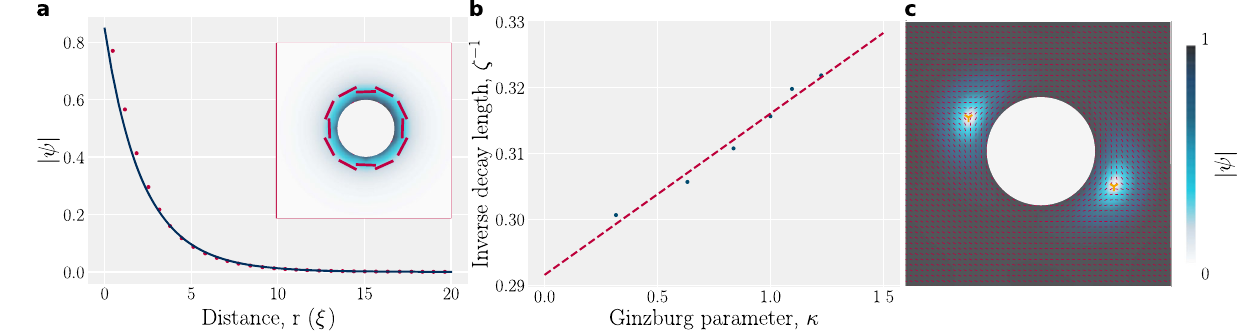
Fig. 4 | Circular inclusions induce local smectic order and set the topological charge of the domain. a A circular inclusion embedded in a bulk isotropic phase showing boundary-induced local lamellar ordering (radius R =5 ξ , A =0.1 (isotropic state), C =2, κ 2 =0.5, anchoring: ψ = e i π /2 , N parallel to the boundary). Exponential decay of lamellar order ∣ ψ ∣ with distance from the surface r . (inset) Snapshot of ∣ ψ ∣